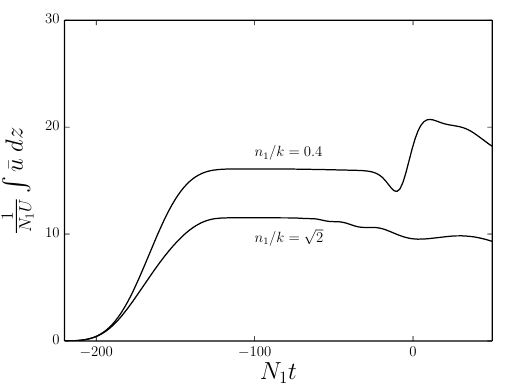
Figure 18. Temporal evolution of the vertical integral of the mean velocity for n 1 /k = 0.4 and n 1 /k